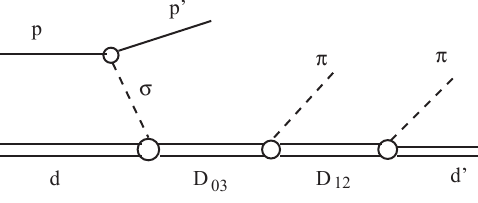
Figure 3. Two resonance mechanism of the reaction pd → pd ππ (see